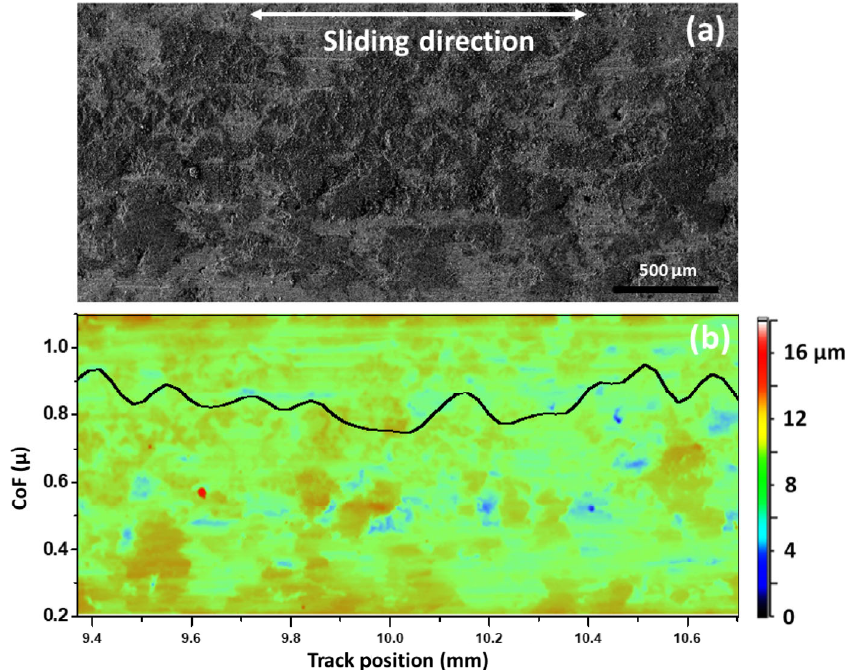
Fig. 11 Instantaneous CoF with surface profilometry indicating higher average CoF throughout the wear